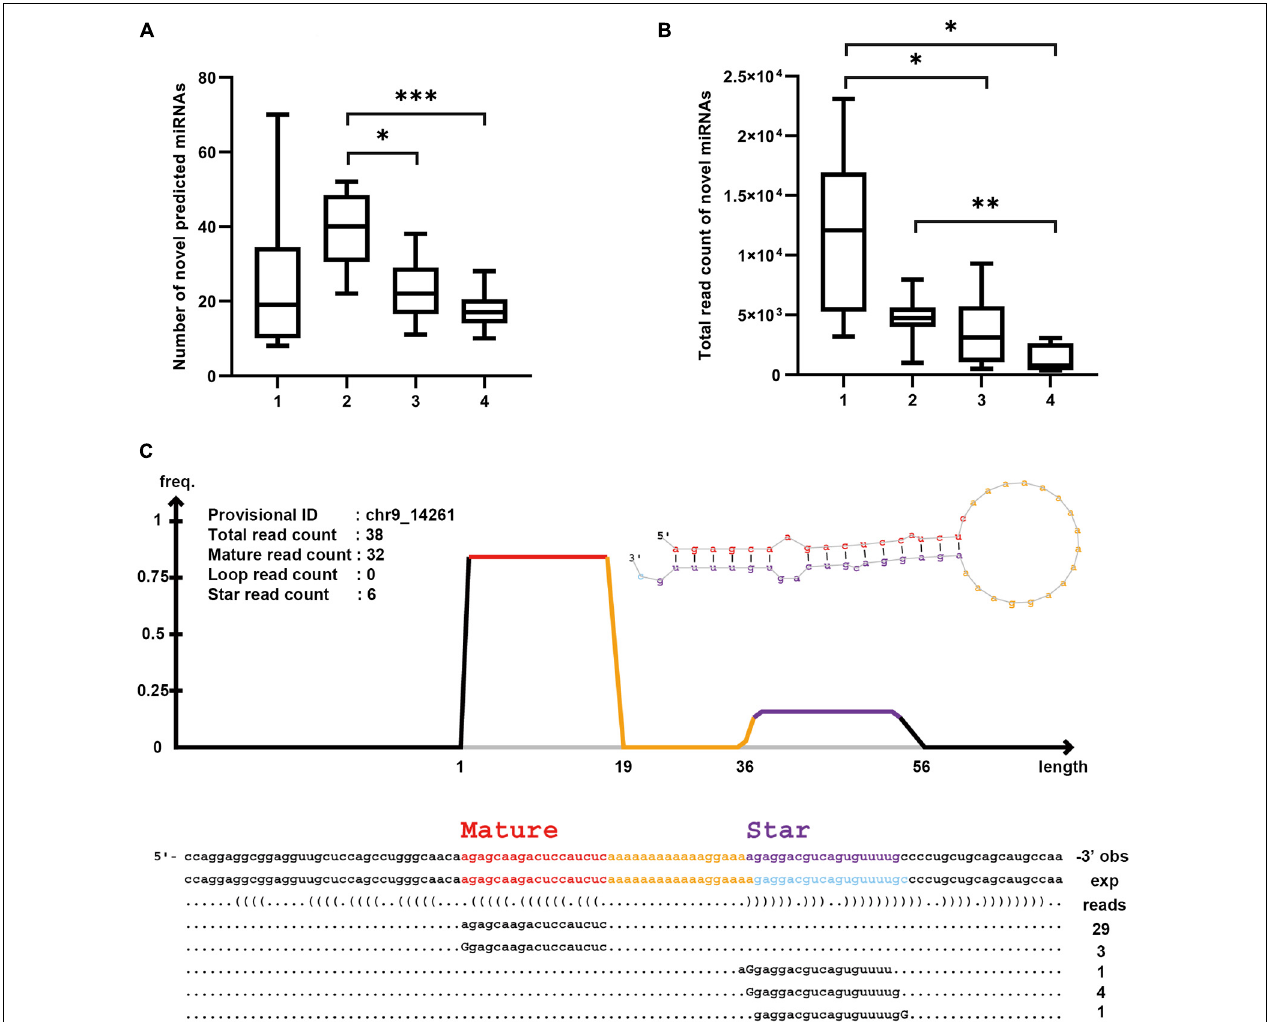
FIGURE 7 | Novel miRNA prediction by miRDeep2. (A) Number of novel predicted miRNAs in each fraction (* p < 0.05, ** p < 0.01, *** p < 0.001, one-way ANOVA). (B) Total read count of predicted novel miRNA in each fraction (* p < 0.05, ** p < 0.01, *** p < 0.001, one-way ANOVA). (C) Novel miRNA on chr9_14261 (EV Precipitate, sample 10). Upper left shows the information about the sequences in the region. Upper right shows the secondary structure of the miRNA. Below are the mapped sequences on both star and mature strands. Number on the bottom right is read count of mapped sequences. Mismatched nucleotides are indicated by uppercase